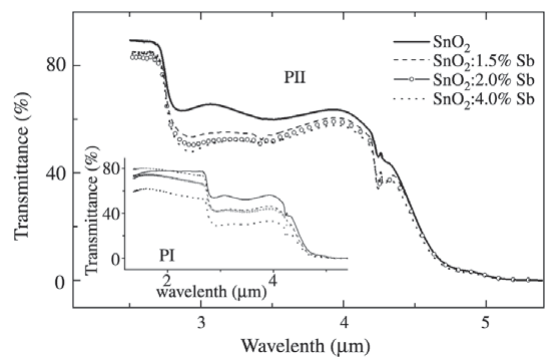
Figure 1. Near infrared transmittance spectra of SnO deposited by PII with several Sb doping composition. Inset - near infrared transmittance spectra of films deposited by